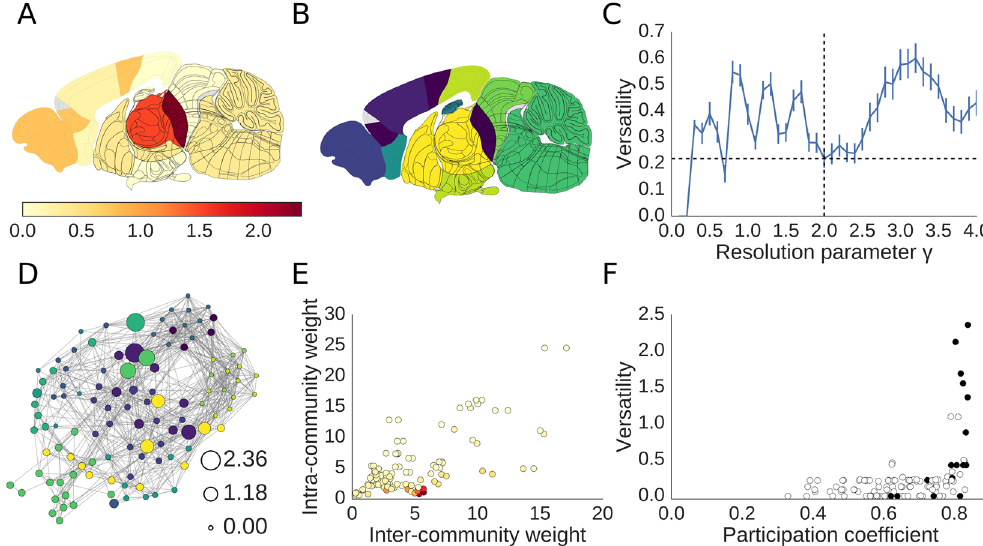
Figure 4. Versatility in the mouse connectome. ( A ) The versatility of each region in the mouse brain, plotted anatomically. ( B ) An example classification of the communities in mouse at an optimal resolution parameter, determined using the curve shown in ( C ). Error bars represent SEM. ( D ) A topological view of the mouse connectome. Nodes are coloured by community using the colour scheme from ( B ). The mean versatility is given by the size of the node. ( E ) Versatility is related to inter-community weight and intra-community weight. Highly versatile nodes have low intra-community weight and high inter-community weight. Versatility, indicated by colour, is the mean versatility across resolution parameters. Colours correspond to the colour bar in ( A ). ( F ) Versatility is plotted against participation coefficient, where participation was computed at the resolution parameter from ( C ). Previous work 14 identified several nodes which they called “hi-par” nodes (meaning “high participation”), which are coloured black. The mean versatility of the hi-par nodes is significantly (Wilcoxon- Mann-Whitney p < 0.001) different from the non–hi-par